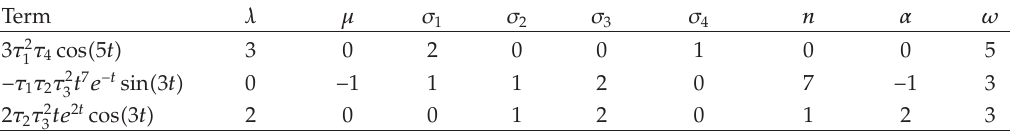
Table 1: Some examples of representation of